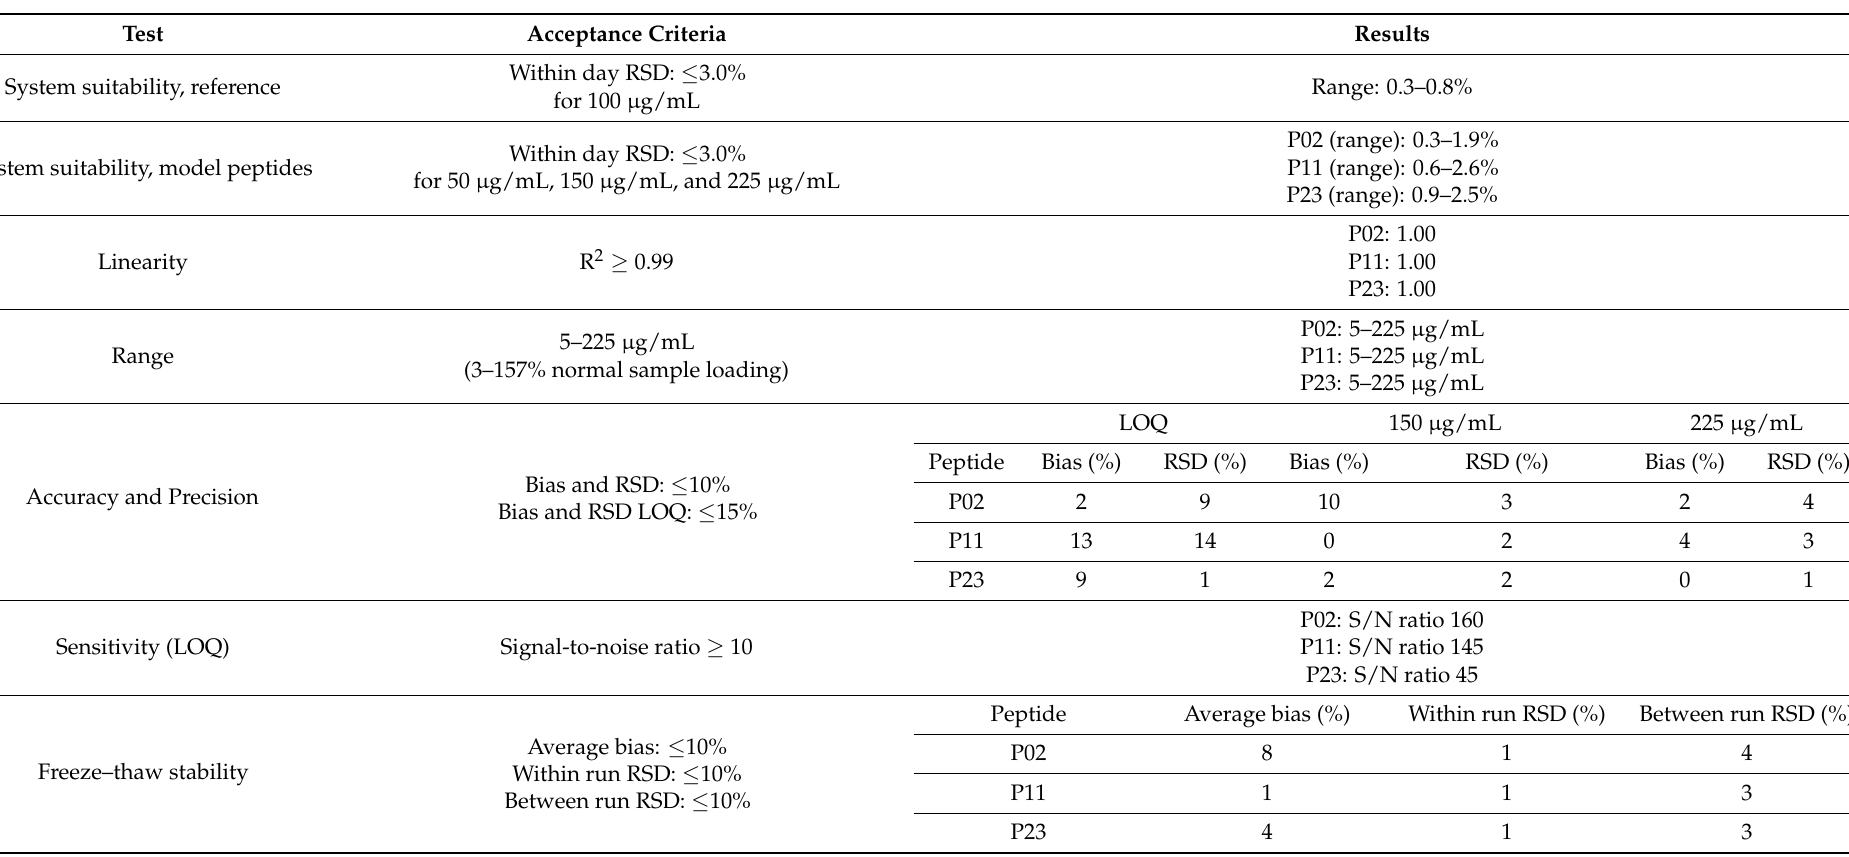
Table 8. The validation results of the stability-indicating LC-MS analytical method. FRM001P02, FRM001P11, and FRM001P23 are designated P02, P11, and P23,